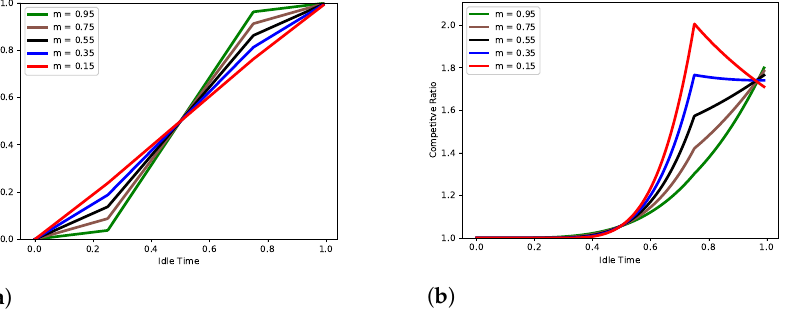
Figure 8. Fixed duration = 0.25. ( a ) Online strategies for piece-wise linear functions, general system; ( b ) competitive ratios for piece-wise linear functions, general system.